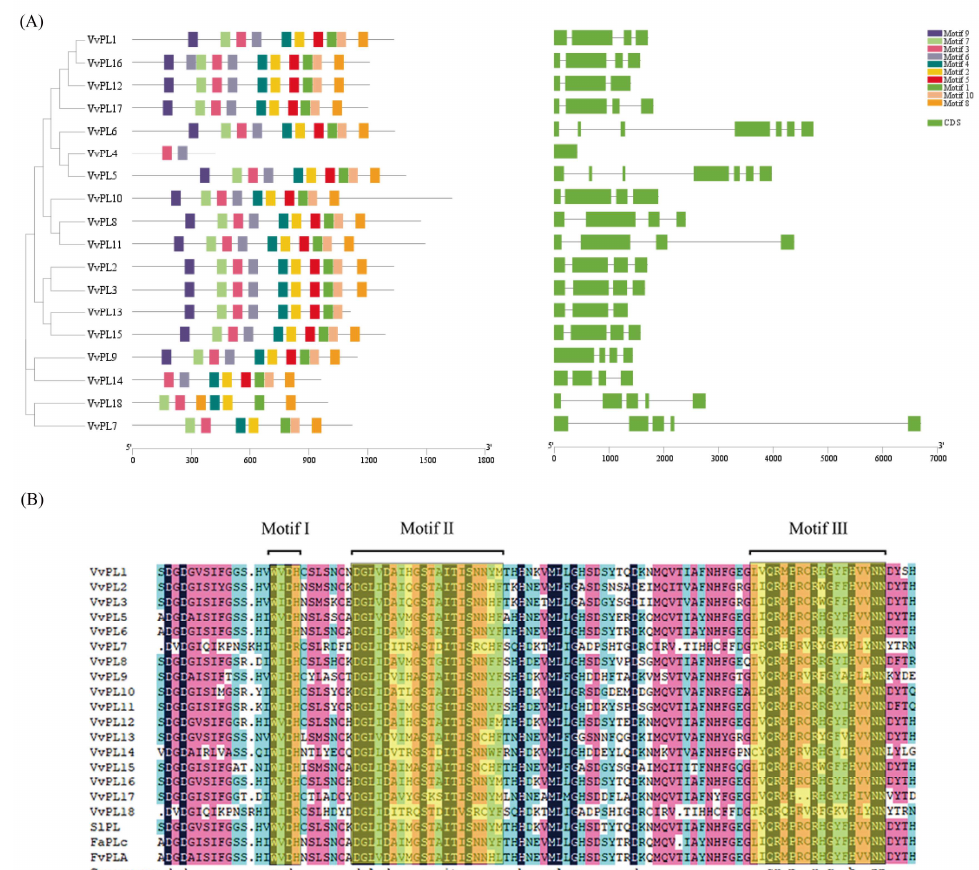
Figure 3. Characterization of PL family members in V. vinifera and other species. ( A ) Phylogenetic relationships, motifs, and exon/intron structures of VvPLs . The left part represents the phylogenetic tree of VvPL proteins. The middle part displays the conserved motifs of VvPLs. Different motifs are represented by blocks of different colors. The right part indicates the exon–intron distribution of VvPL genes. ( B ) Amino acid sequence alignment of V. vinifera VvPLs with other PLs. Orange shading indicates three typical conserved motifs of PLs, which were referred to as motif I, II and III respec- tively.